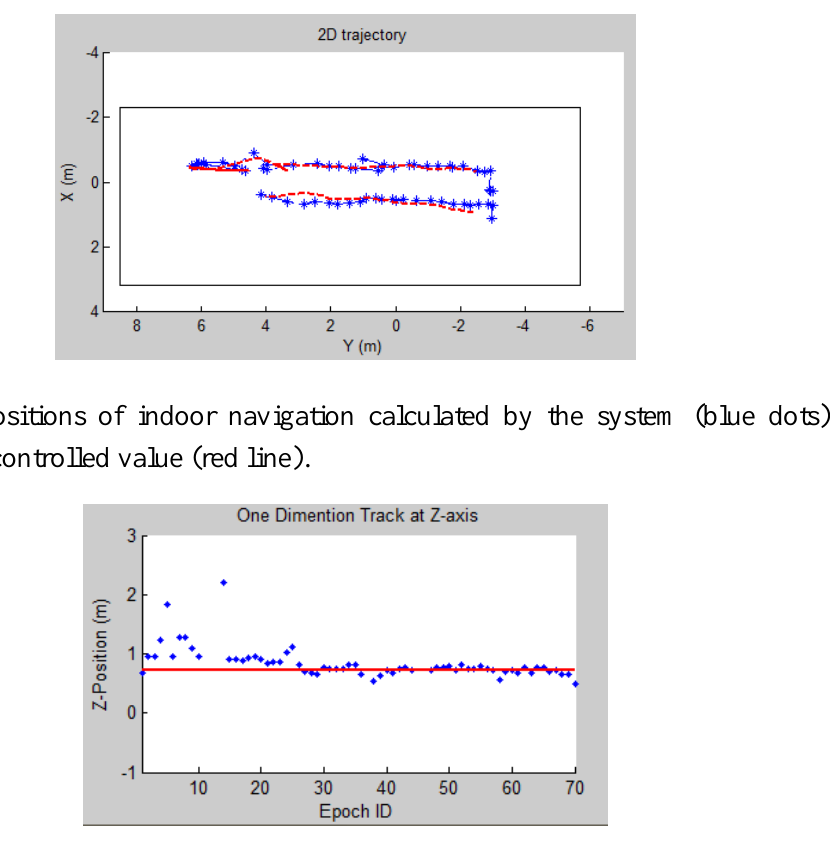
Figure 24. Two dimensional trajectory of indoor navigation recovered by the image-based system (blue line) with reference to the Photomodeller results (red line).